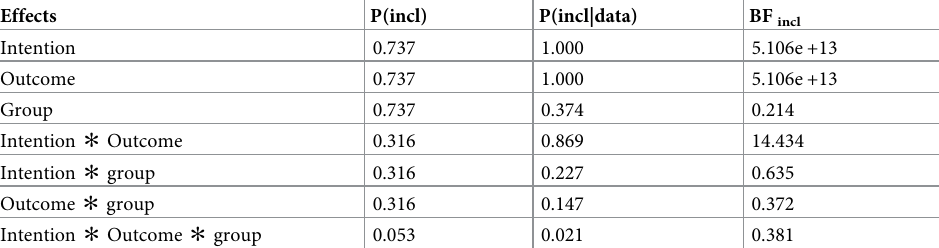
Table 4. Bayesian repeated measures ANOVA: Analysis of